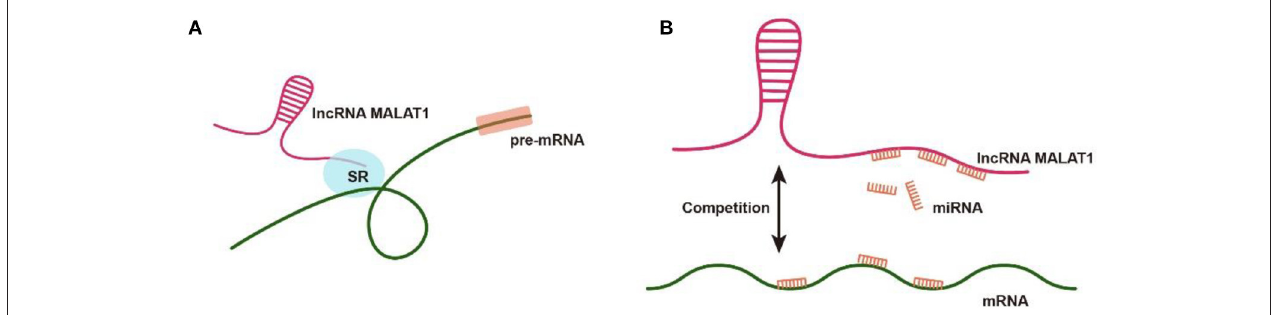
FIGURE 1 | Molecular Function of MALAT1. (A) The transcriptional regulation of MALAT1 by interaction between MALAT1 and SR splicing factors. (B) The post-transcriptional regulation of MALAT1 via competitive ceRNAs.